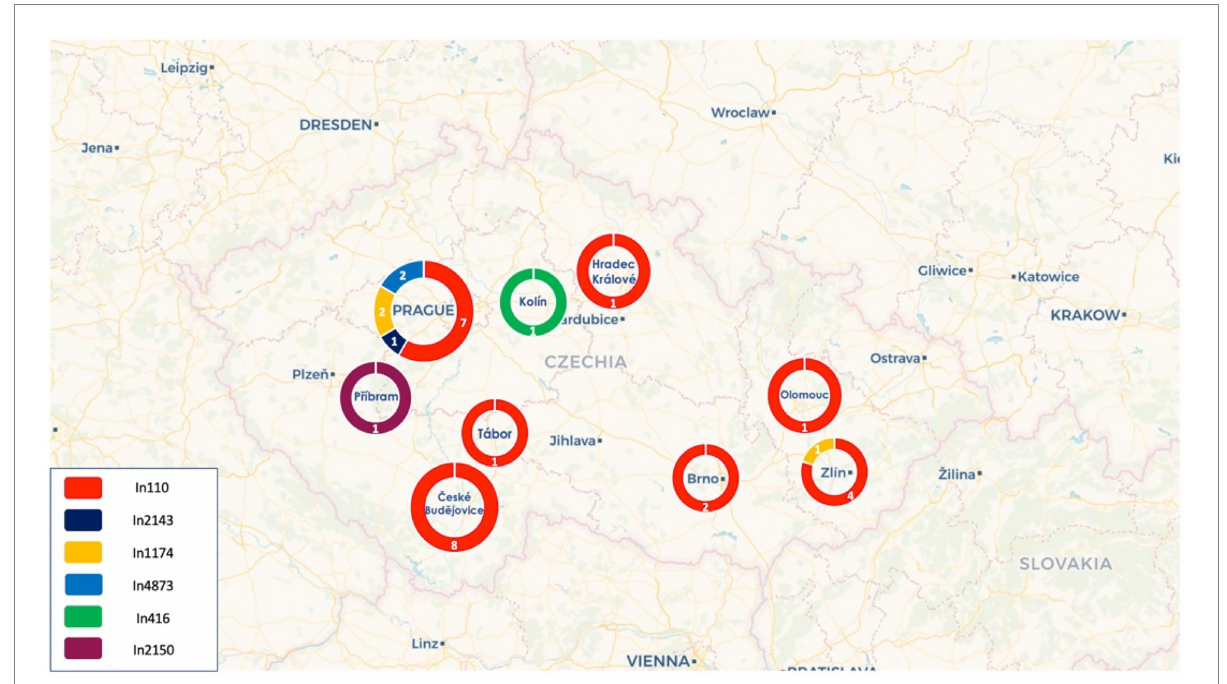
FIGURE 1 Distribution of the different integrons across the cities in the Czech Republic.